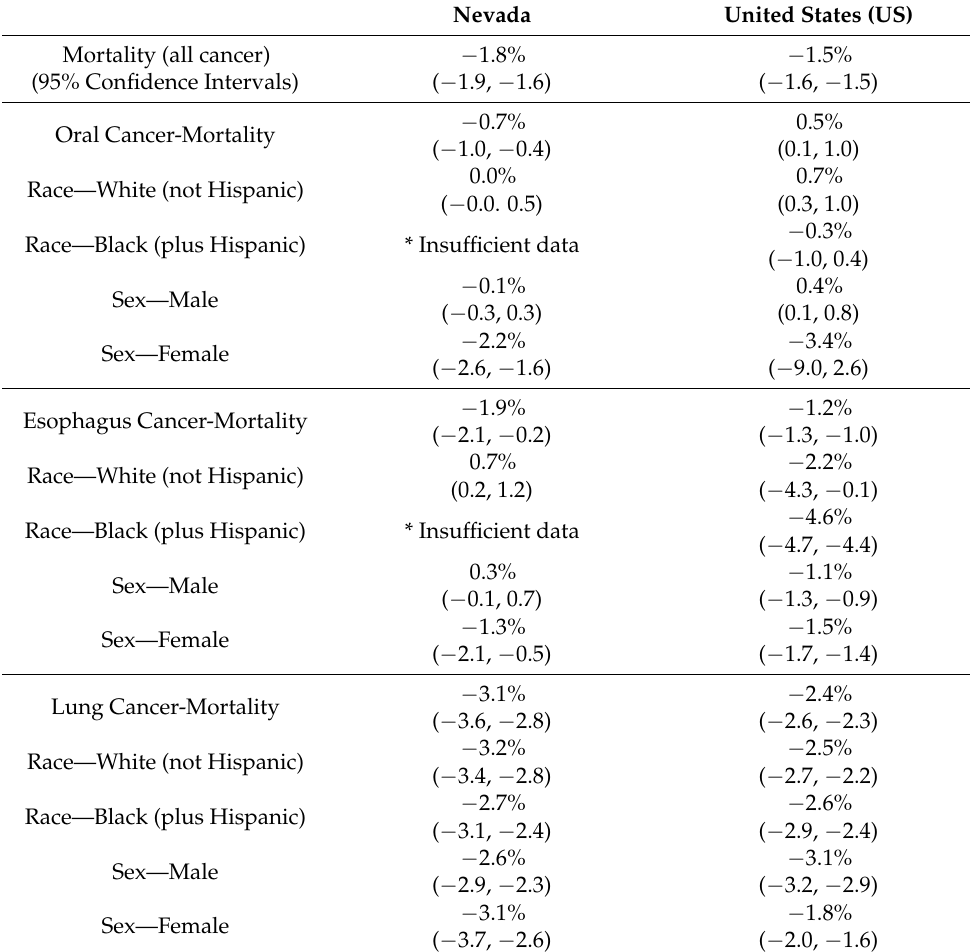
Table 2. Comparison of National (US) and Nevada-specific mortality rates of oral and pharyngeal, esophageal and lung